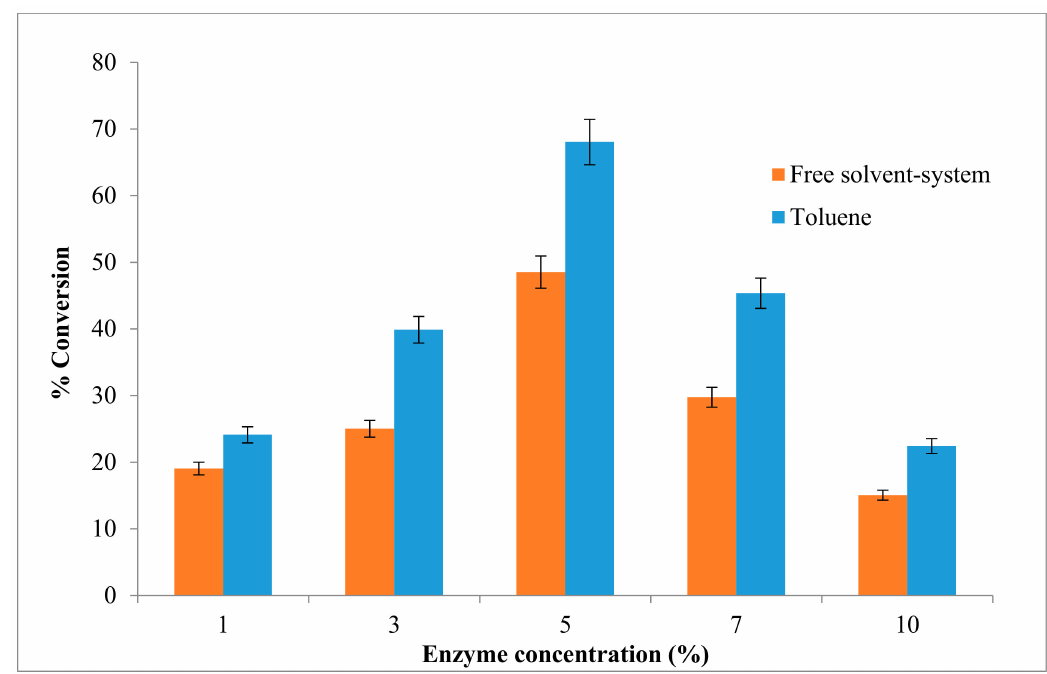
Figure 5. Effect of different concentration of enzyme on AMS8 lipase in toluene and free-solvent-system. Percentage conversion of ethyl hexanoate catalysed by native AMS8 lipase as affected different of enzyme concentration in toluene and free-solvent system. Reactions were performed at 20 ◦ C for two hours 25 mM of substrate concentration (1:1 molar ratio ethanol to hexanoic